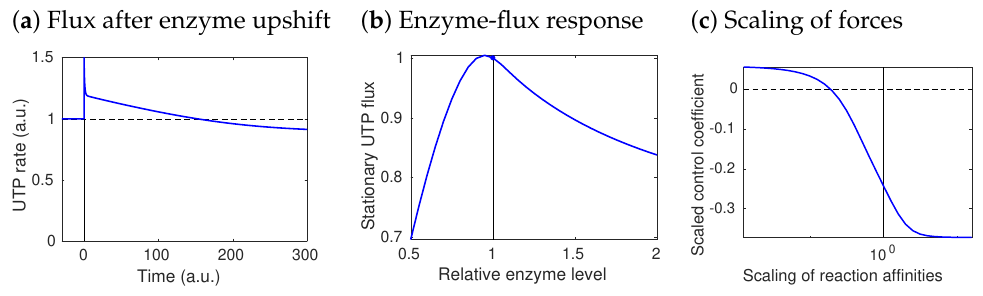
Figure 4. Paradoxical flux control: a model of UTP rephosphorylation in human hepatocytes. Fluxes in central metabolism were obtained in [53] by FBA with UTP production as the objective. Here, flux control coefficients were obtained by STM with standard elasticities, i.e., saturation values of 0.5. Paradoxically, the UTP-regenerating enzyme NDK has a negative control over its own flux. ( a ) Metabolic dynamics after an NDK upshift. A higher NDK activity first speeds up the reaction, but later the rate drops below its initial value. ( b ) Dose–response curve between NDK amount and steady-state UTP production. In the reference state (vertical line), the curve slope (response coefficient) is negative: an enzyme increase decreases the flux. ( c ) The response coefficient depends on thermodynamic forces. To see this, all thermodynamic forces were increased by a common factor ( x -axis): with higher thermodynamic forces, the response ( y -axis) becomes more